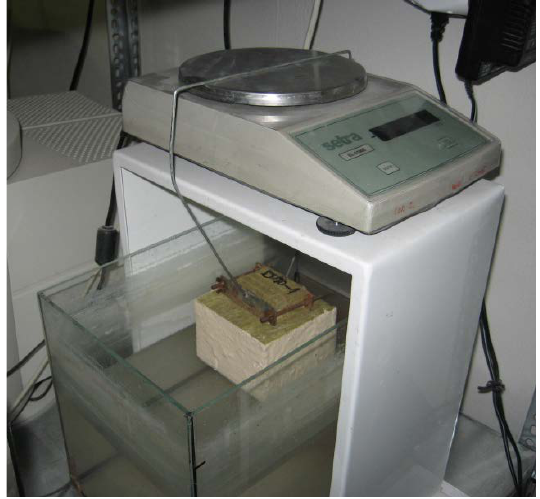
Figure 5. Experimental setup for the automatic measurements of water sorptivity.